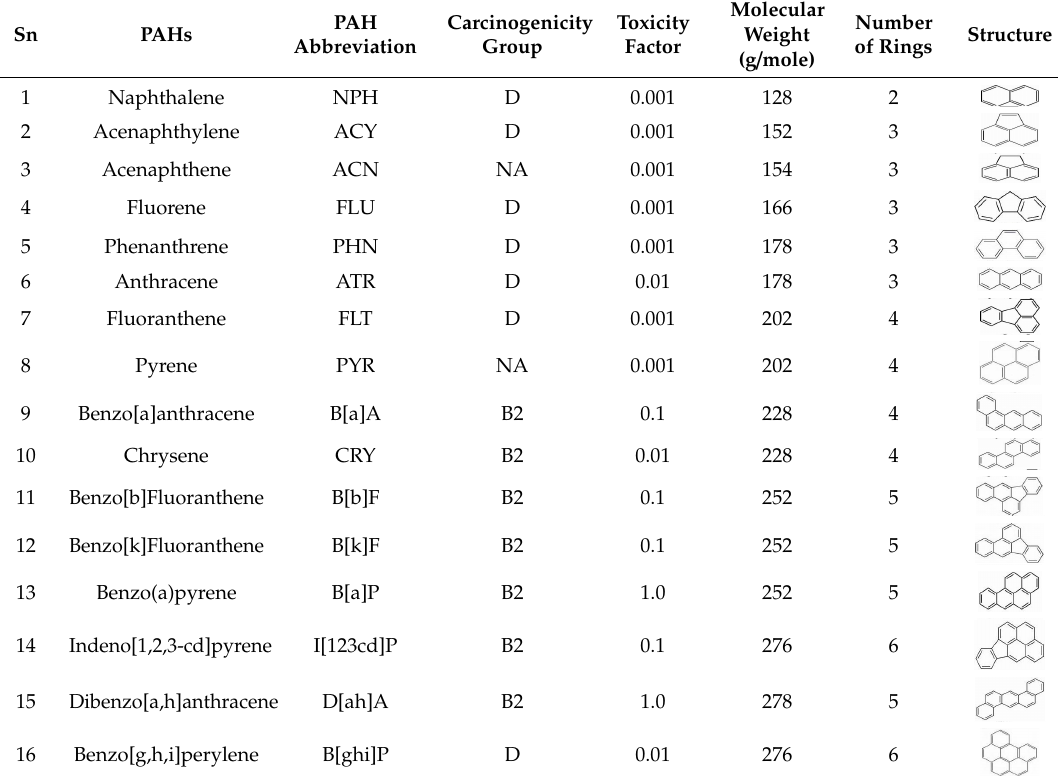
Table 1. List of 16 priority polycyclic aromatic hydrocarbons (PAHs) and their carcinogenic groups as classified by US EPA (1993). Group B2 are ‘possibly carcinogenic to humans’ while Group D are ‘unclassifiable as to carcinogenicity’ NA—Not available. Molecular PAH Carcinogenicity Toxicity Number PAHs Weight Abbreviation Group Factor of Rings (g/mole)